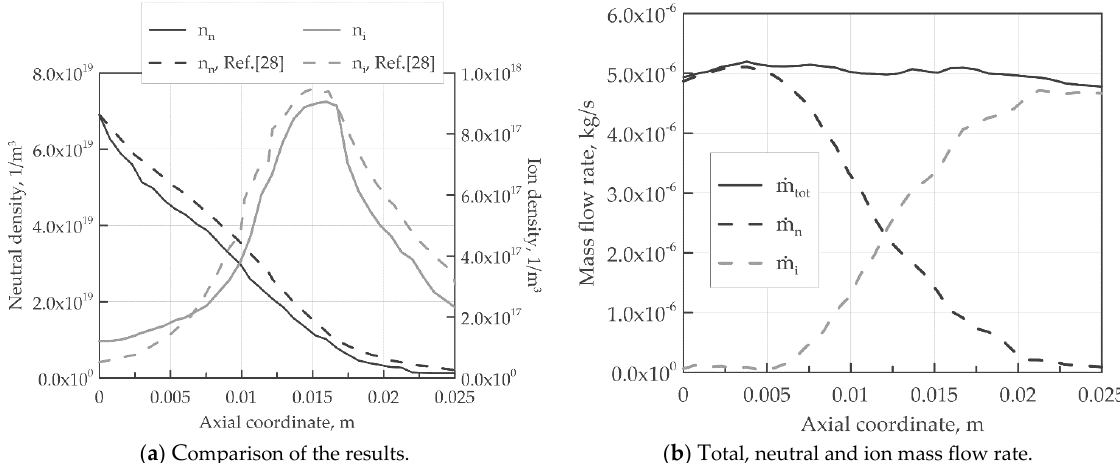
Figure 7. A comparison of the results obtained by the current model and that in [37] ( a ) and a representation of the total mass flow rate with the neutral and ionized contributions ( b ).